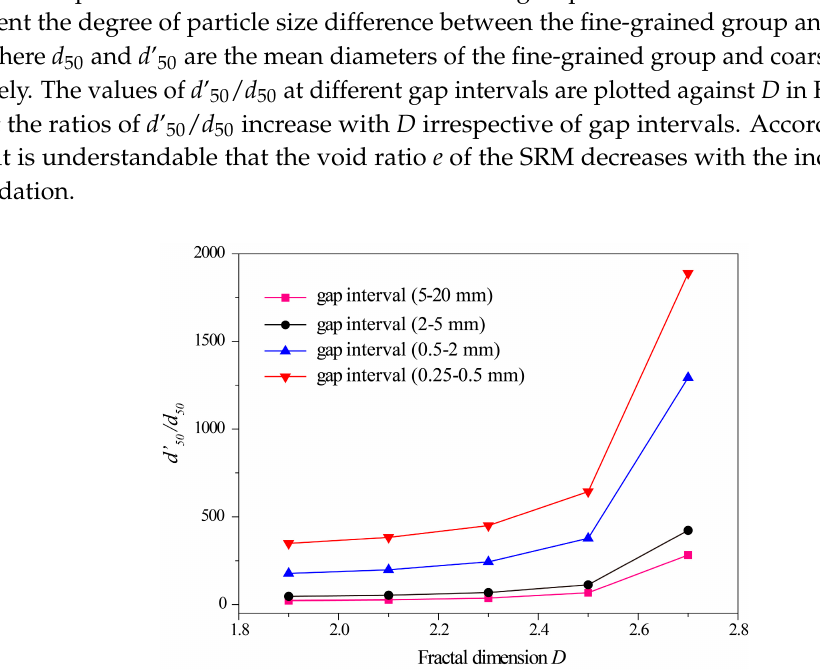
Figure 6. Changes of d ’ 50 /d 50 with fractal dimension D at different gap intervals.